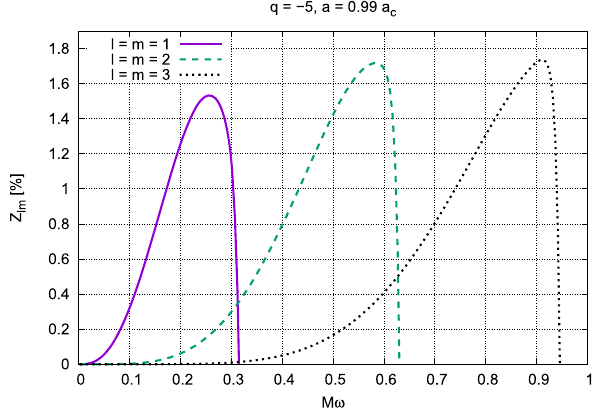
Fig. 7 Amplification factors for q = − 5, a = 0 . 99 a c and modes l = m = 1 , 2 , 3. Grid lines help us to verify that in such case maximum amplification occurs for l = m = 3